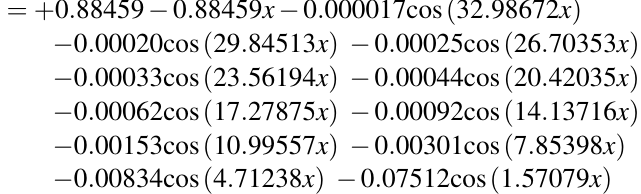
Table 1. Some α , (cid:107) u ( 0 , t ; v